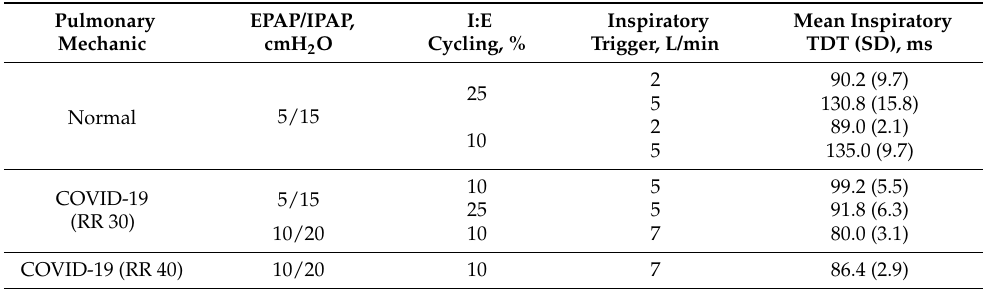
Table 2. Inspiratory trigger delay time.